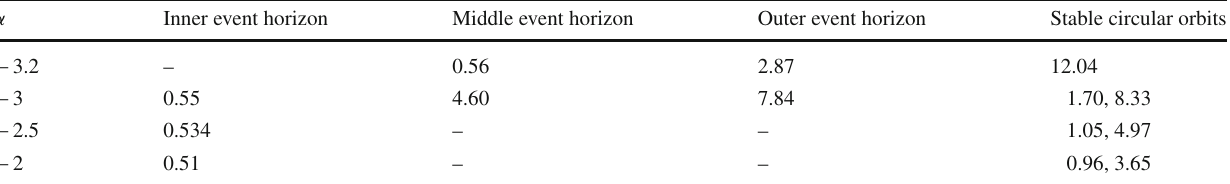
Table 3 Location of the event horizons and the stable circular orbits for the second case ( β = 2 . 1) and different values of α around the black hole in dRGT massive